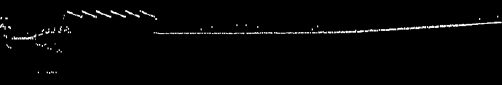
Figure.2 Profile for man-made coast.